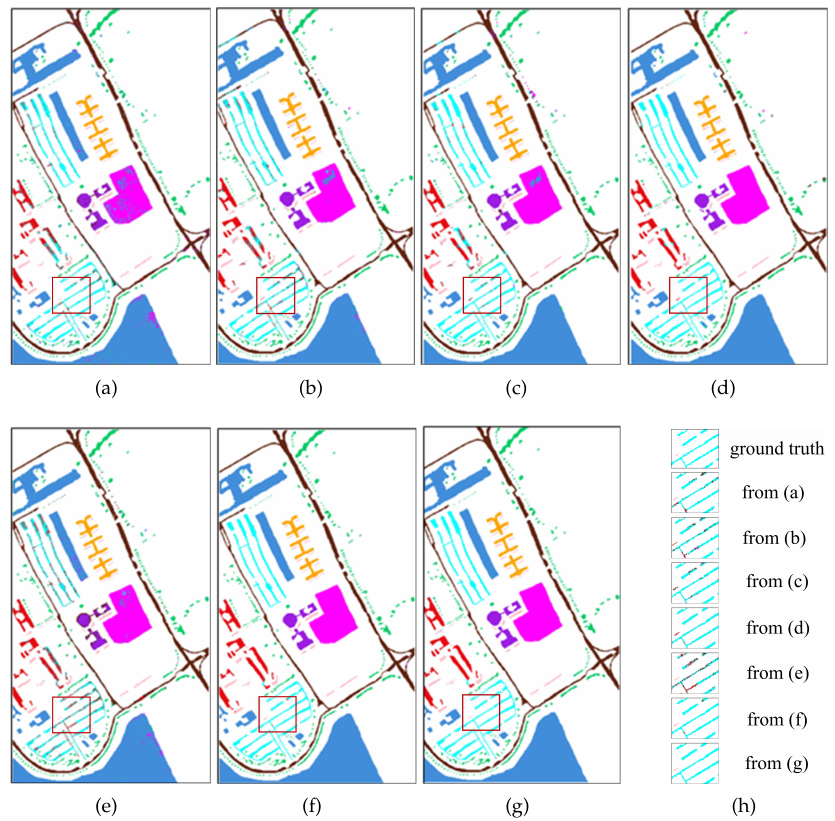
Figure 13. The classification maps of the PU dataset. ( a ) SVM. ( b ) 2D-CNN. ( c ) 3D-CNN. ( d ) Hy- bridSN. ( e ) ViT. ( f ) SSFTT. ( g ) SDFE. ( h ) The enlarged